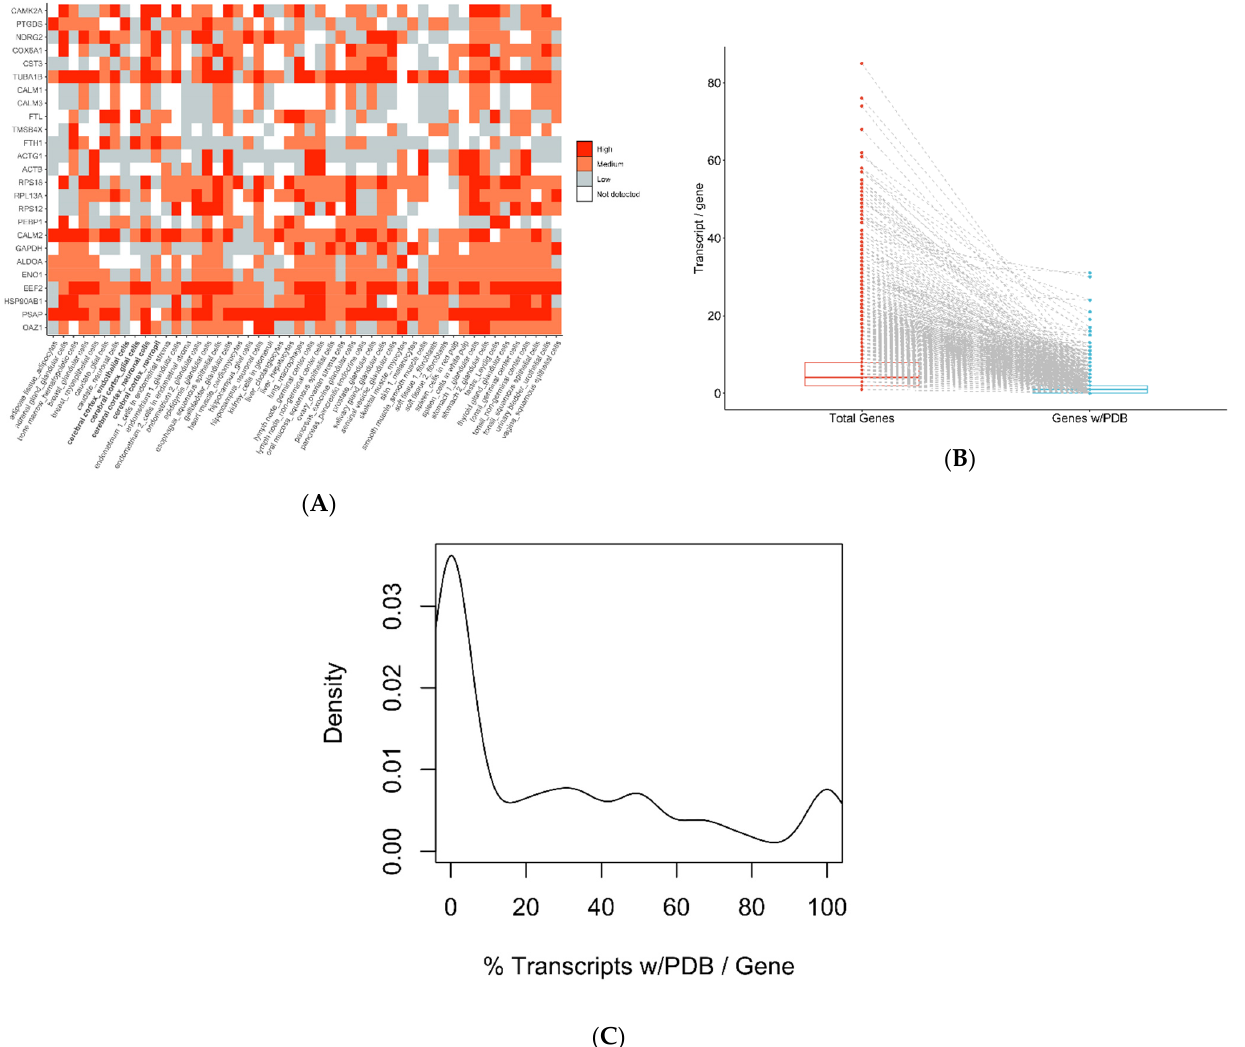
Figure 7. Protein detection and available PDB structures: ( A ) Tissue protein profiles of 25 of the 50 most expressed genes in the brain cortex from GTEx. ( B ) Gene transcripts from the TSOex panel with and without PDB IDs. ( C ) Transcript abundance with PDB IDs. In Figure 7A, proteins with no available data in >50% of the analyzed tissues from the Protein Cell Atlas were removed. In Figure 7B, the connecting dotted lines link the numbers of all transcripts from one gene with the amounts of these transcripts with PBD IDs.